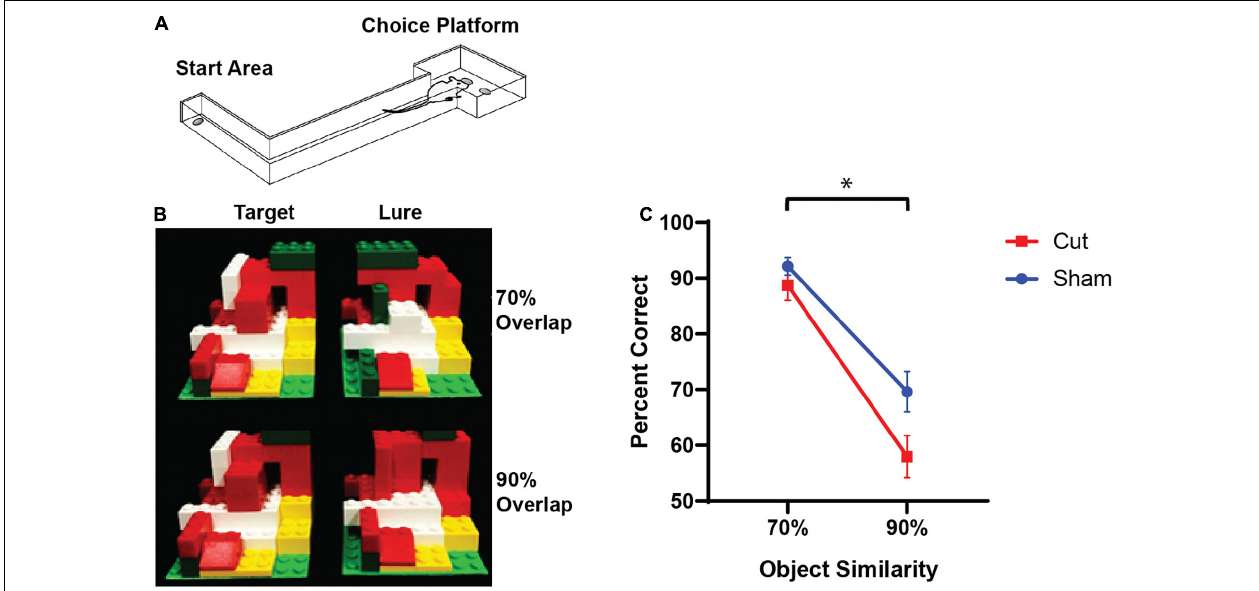
FIGURE 1 | The rodent mnemonic discrimination task. (A) Schematic of the L-shaped apparatus used for both training and testing discrimination ability in rats. (B) The LEGO block object pairs used in testing. Rats were trained to identify the target object as correct compared to either a 70% (top) or 90% (bottom) visual overlap object. (C) Mean percent correct trials on target-lure discrimination task (n’s: Sham = 12